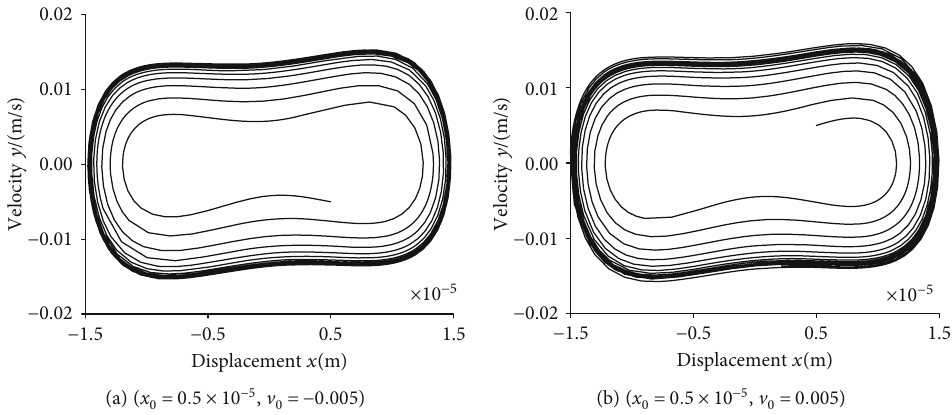
= 1 : 6A , q = 1 : 0 × 10 − 4 m 3 /s 0 0